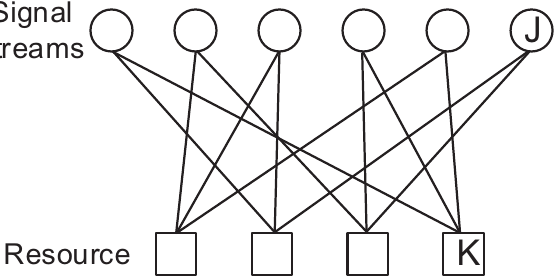
Figure 2. Factor graph of SCMA with 6 signal streams and 4